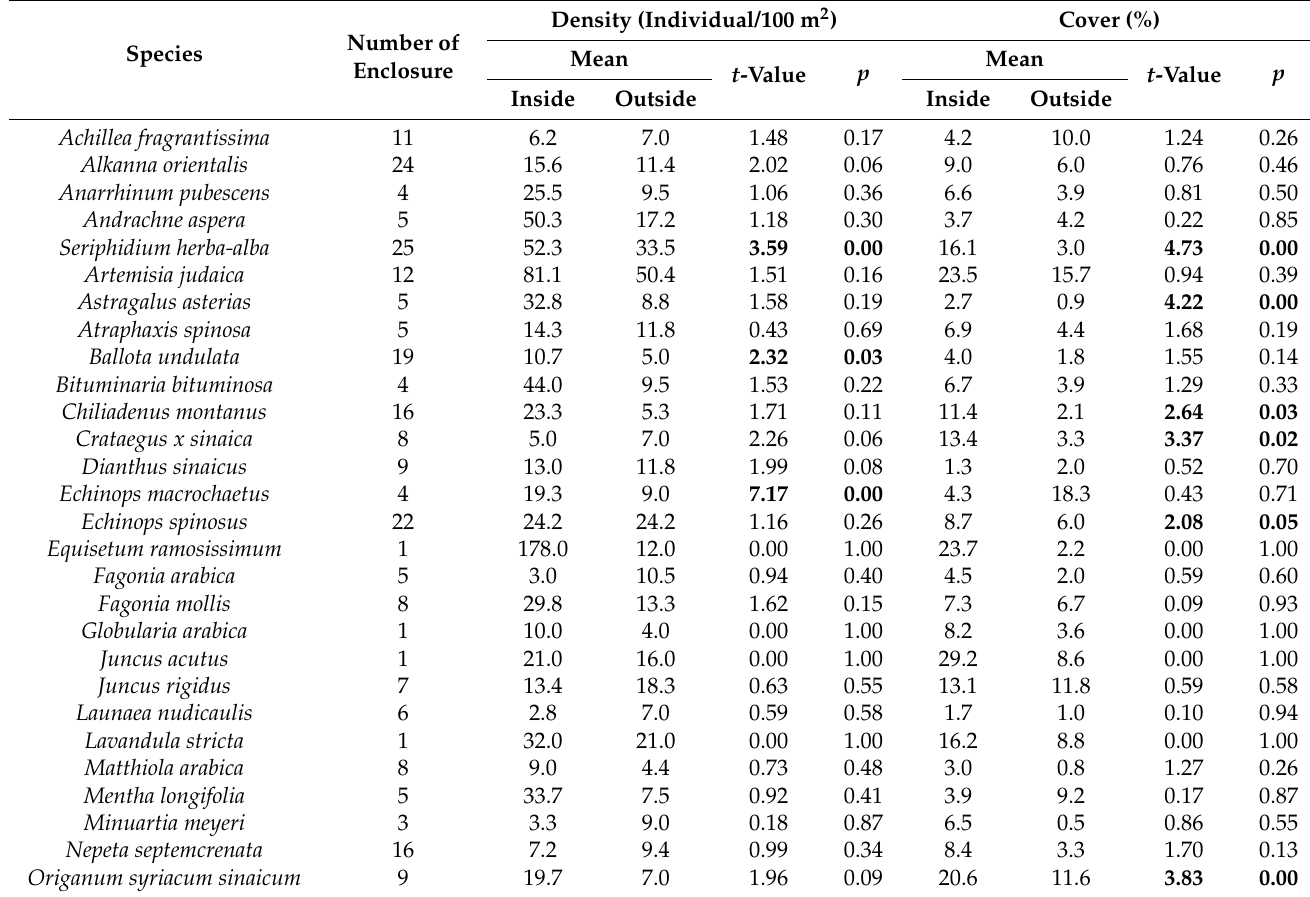
Table 2. The mean densities and covers of the recorded species inside and outside the enclosures, with the number of enclosures in which the species were recorded. Values of t with p ≤ 0.05 were written in bold.